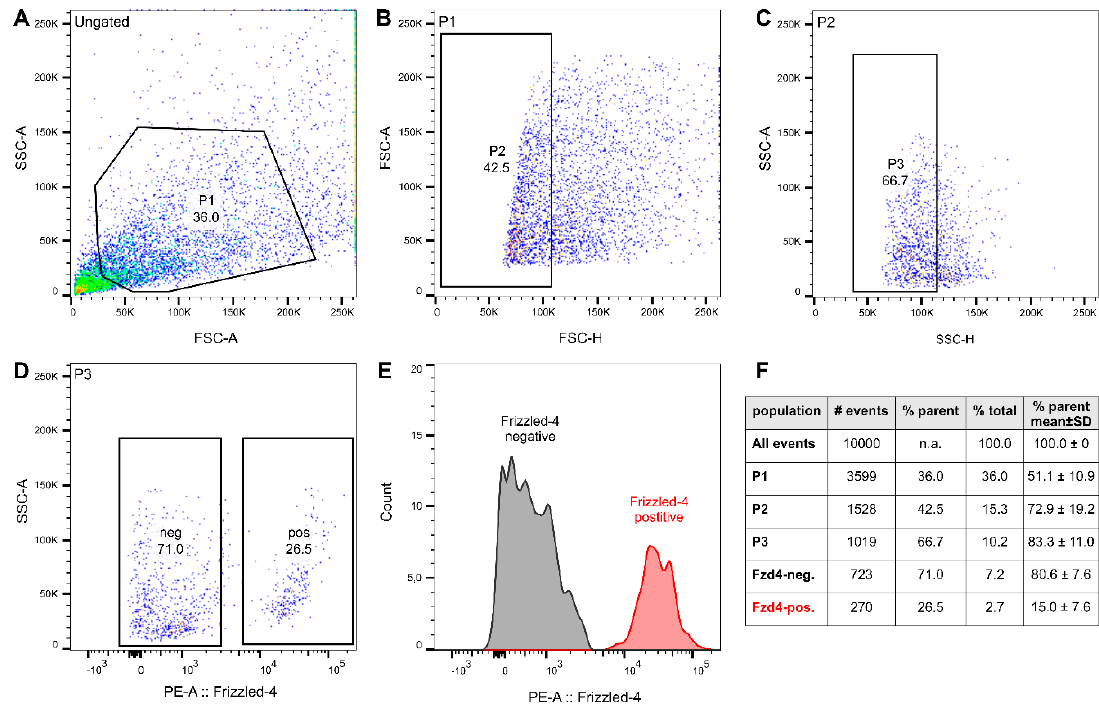
Figure 1. Expression of Fzd4 and P75 NTR in vivo and in Tunica muscularis -derived enterospheres. The micrographs show immunostainings for Fzd4 (green) and P75 NTR (red) in cryosections from Tunica muscularis ( A ) and Tunica muscularis -derived enterospheres ( B ). Fzd4 is expressed in ganglion cell bodies and neurites within the muscle sheets. There is a pronounced co-expression with the putative stem cell marker P75 NTR . In enterospheres (spontaneously formed, non-purified), the same co-localization can be observed. Moreover, these stainings also illustrate the mixture of different cell types that can be found in unpurified enterospheres, thereby resembling a Tunica muscularis -like microenvironment. Immunohistochemistry in enterospheres is overlayed with differential interference contrast (DIC) images for better orientation. Scale bars: top panels 50 µm, bottom panels 40 µm.